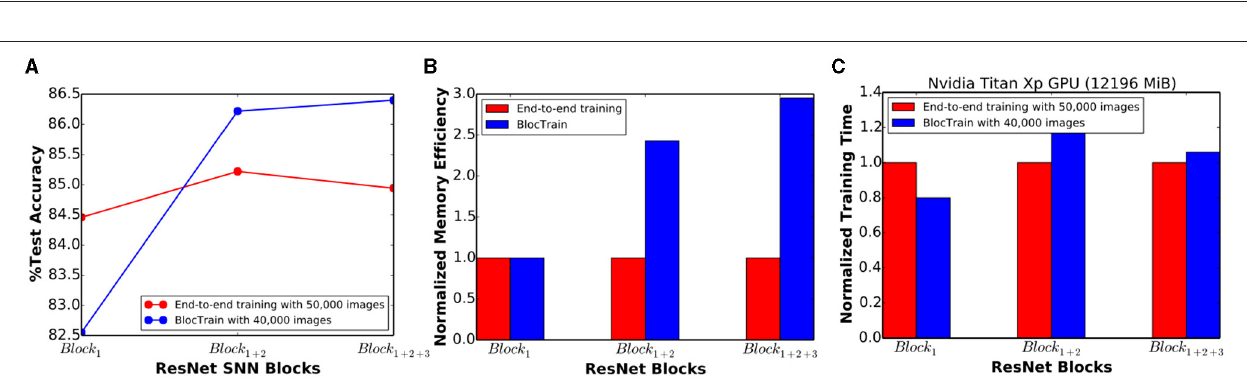
FIGURE 4 | Algorithm to determine easy vs. hard classes based on the class-wise accuracy of ResNet9-block 1 on the CIFAR-10 validation subset. If the class-wise accuracy, Acc cls − wise , is lesser (greater) than the hardness threshold, Acc hard − thresh , the class is categorized as a hard (easy) class.